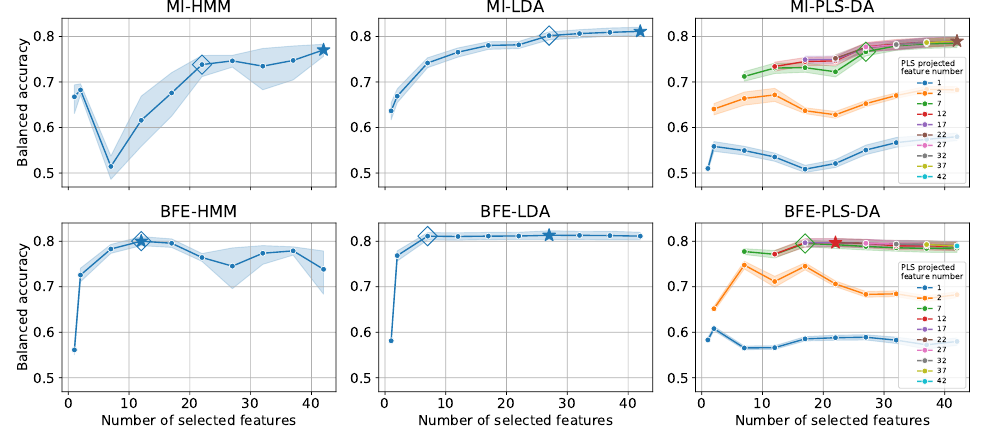
Figure 3. Balanced Accuracy for HMM, LDA and PLS-DA classification algorithms for two feature selection methodologies; MI and BFE for varying number of selected features. For PLS-DA the number of re-projected feature dimensions were varied to explore sensitivity of the hyper-parameter. The (cid:63) denotes models with maximum balanced accuracy performance, while the (cid:5) denotes models that were manually selected and balance the trade-off between balanced accuracy and time